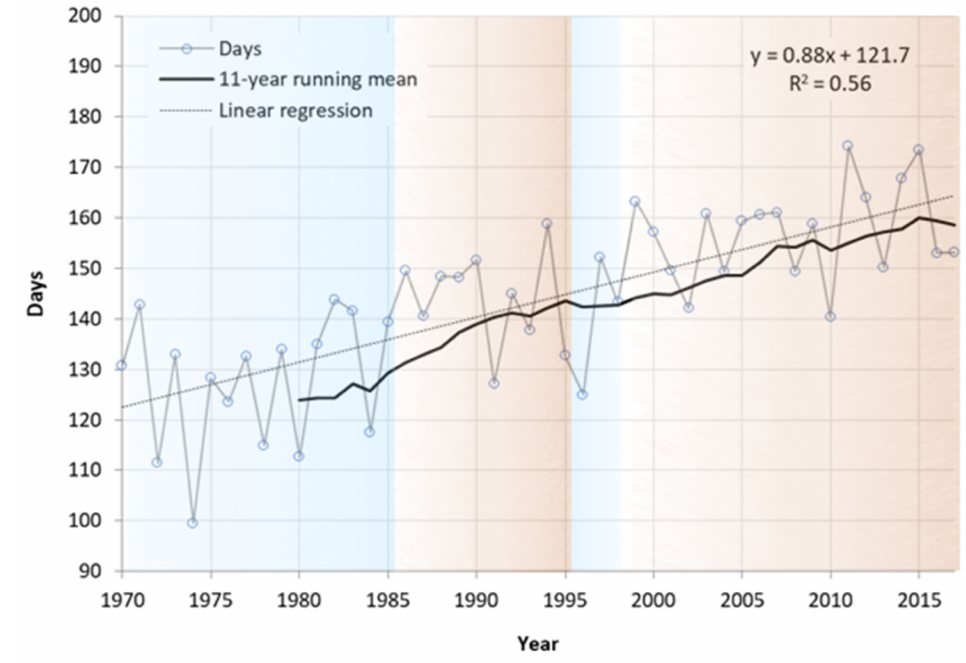
Figure 4. Number of days with the temperature above 0 ◦ C over all glaciers per year. The blue and red shades show the dominant pattern of cold and warm periods below and above 130 days,